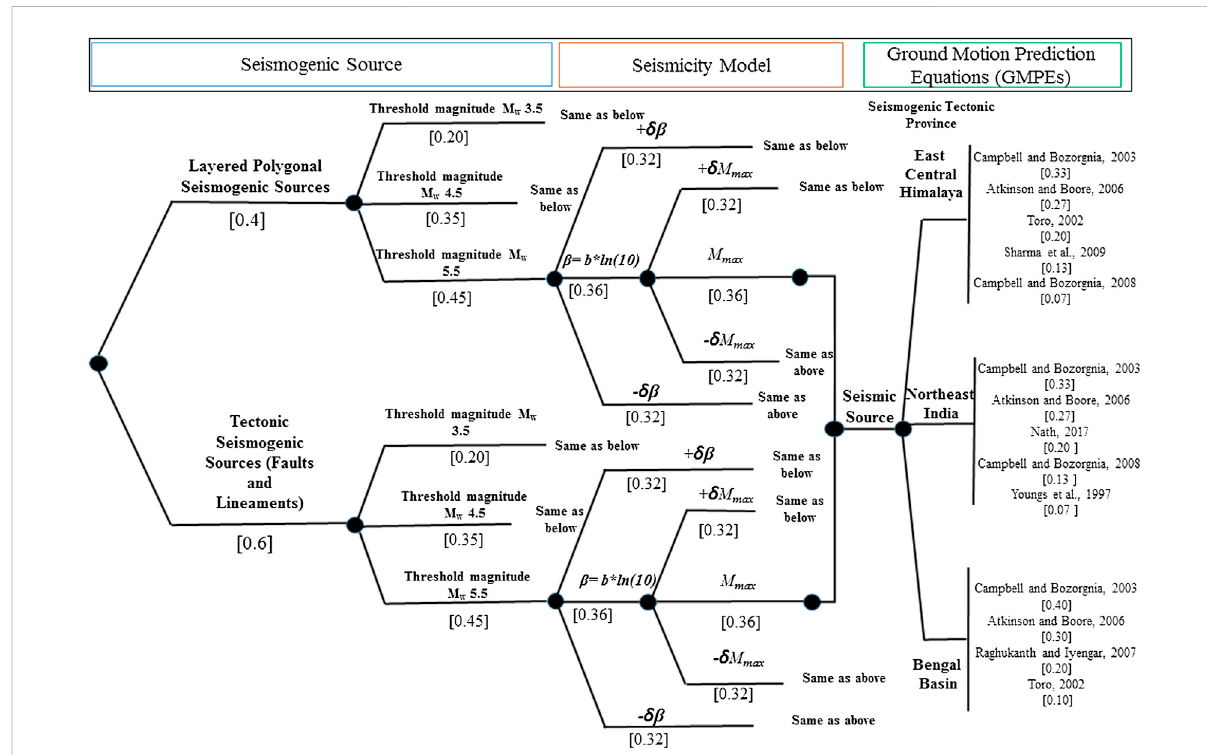
FIGURE 4 Logic tree framework for computing probabilistic seismic hazard at each node of the study region (adopted from Nath et al., 2014; Maiti et al., 2017; and Nath et al., 2021a).